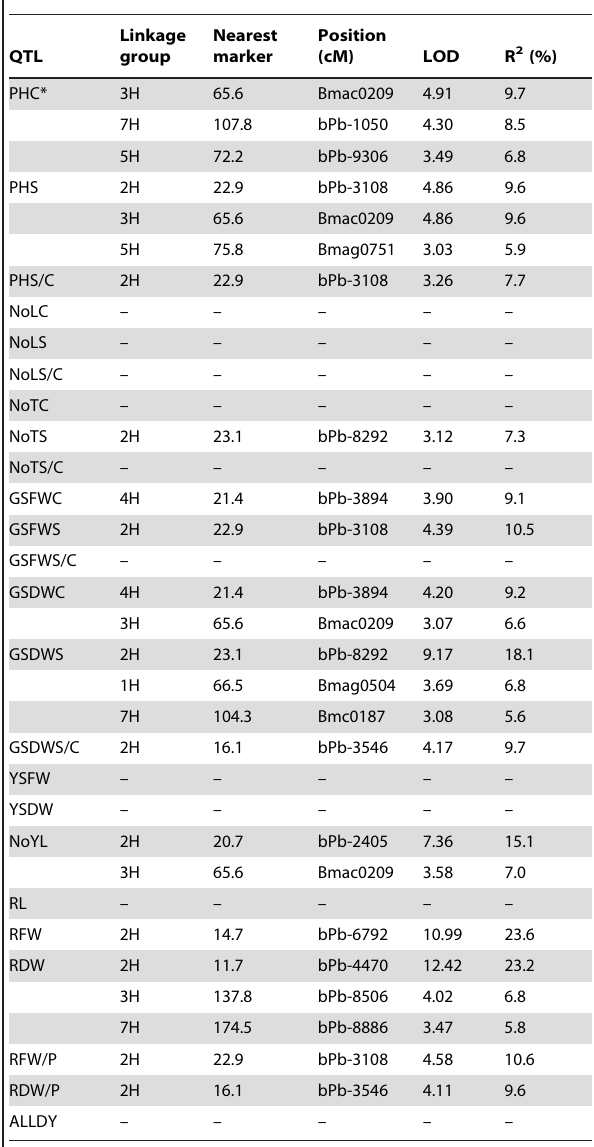
Table 3. QTL identified for different traits under salinity and control conditions in the DH population of TX9425 6 Naso Nijo from hydroponic